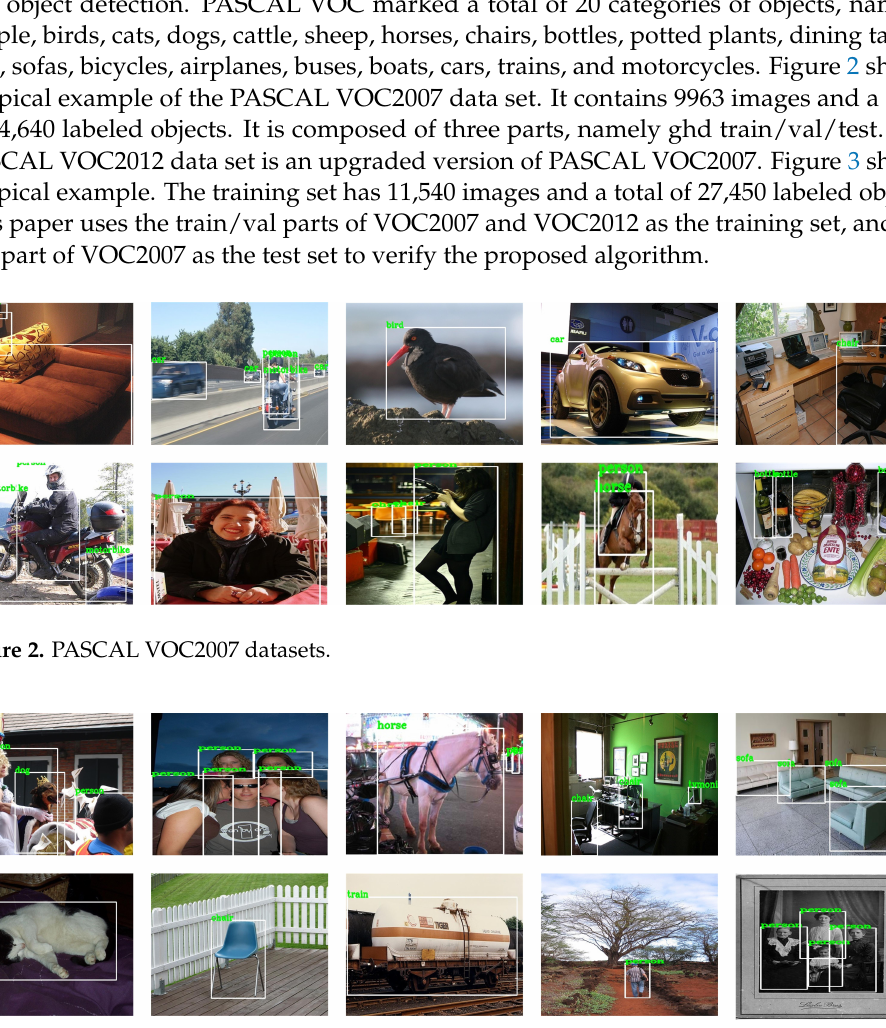
Figure 3. PASCAL VOC2012